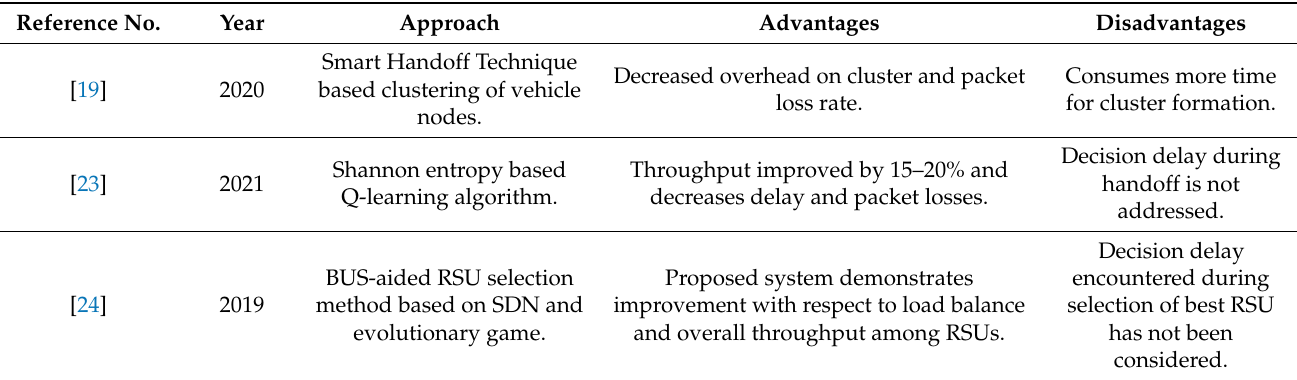
Table 1. Summarization of previous